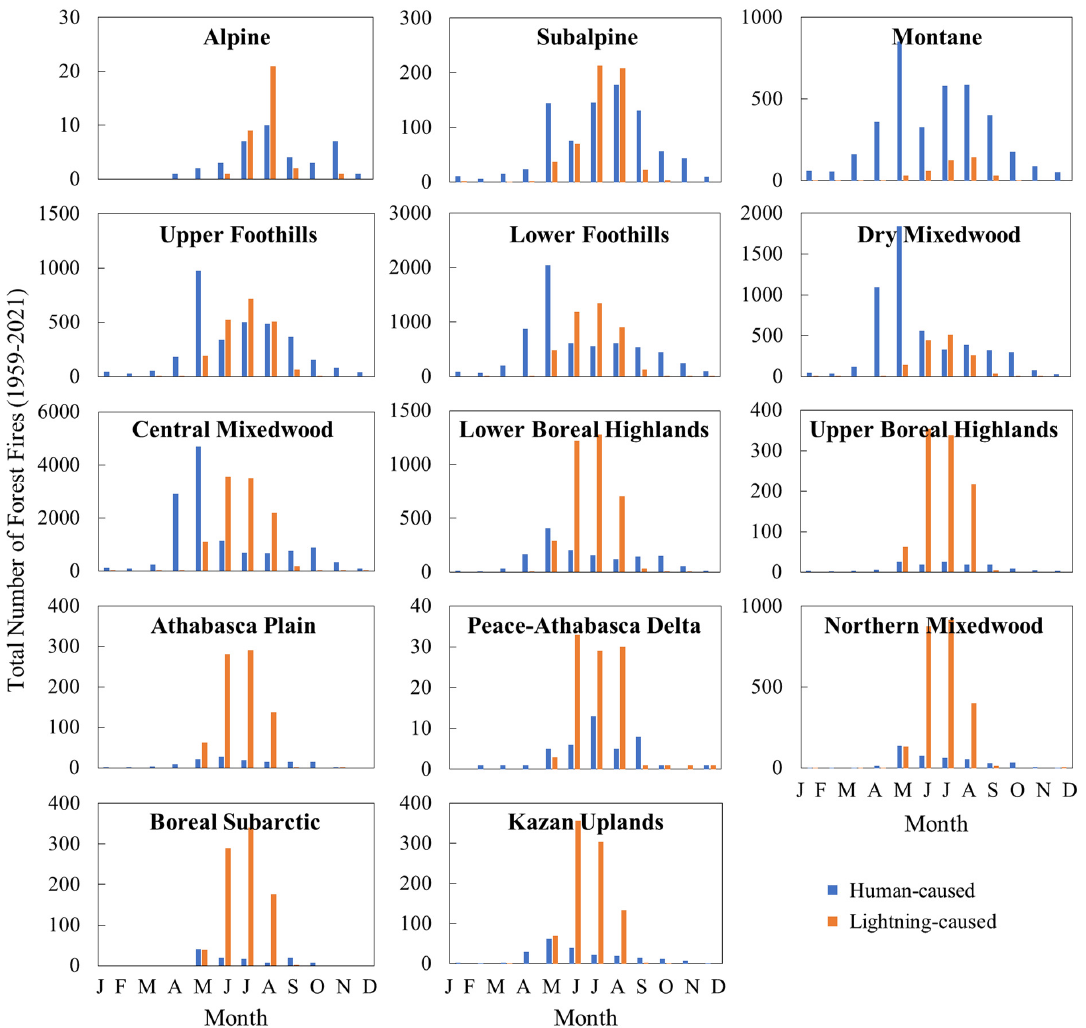
Figure 3. Distribution of human- and lightning-caused forest fires over the months (J = January, F = February, M = March, A = April, M = May, J = June, J = July, A = August, S = September, O = October, N = November, and D = December) of 1959 ‒ 2021 in the 14 subregions.